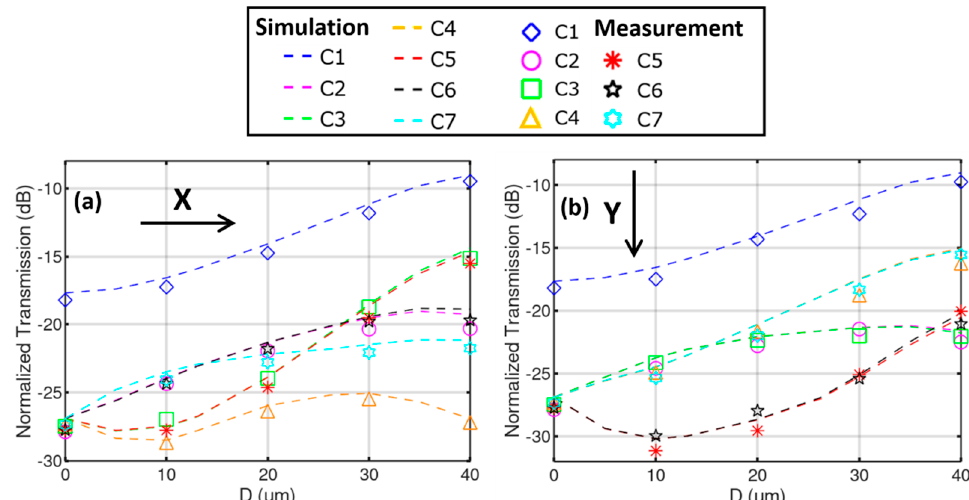
Figure 4. ( a ) Schematic layout and ( b ) photo of the experiment setup. ( c ) Mounting layout for the bent MMF/MMI. ( d ) Simulated and measured power distribution among the 7 output SMFs for the unbent case .